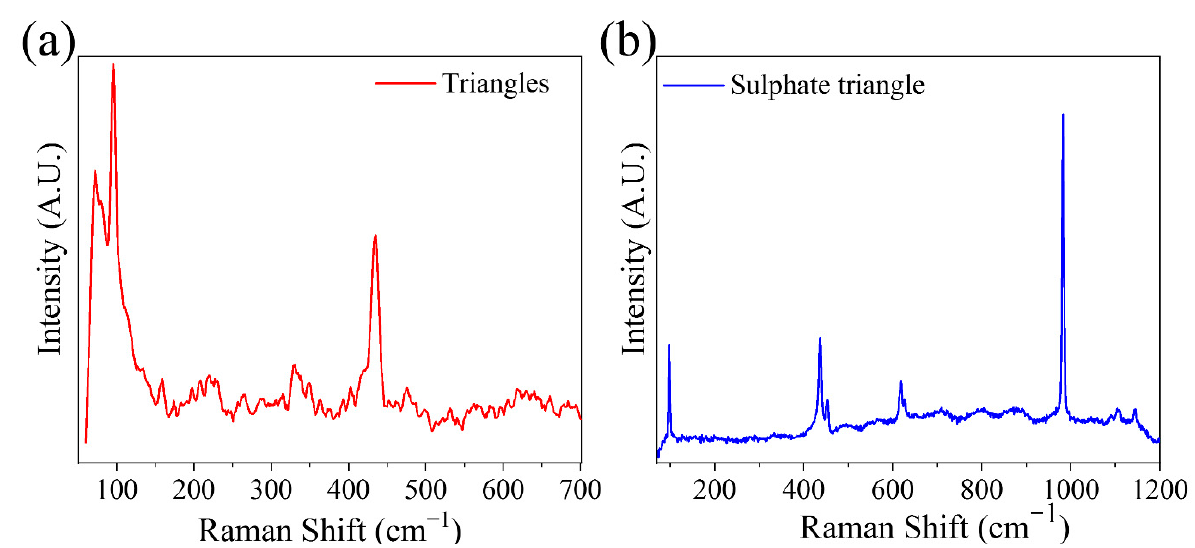
Figure 7. Raman spectra of triangle-shaped structures. Measurements on ( a ) a structure of uncoated triangles and ( b ) with growth of this second material. Table 2. Raman modes detected in the spectra on the coated triangles. The values are consistent with those reported in [37] for K 2 SO 4